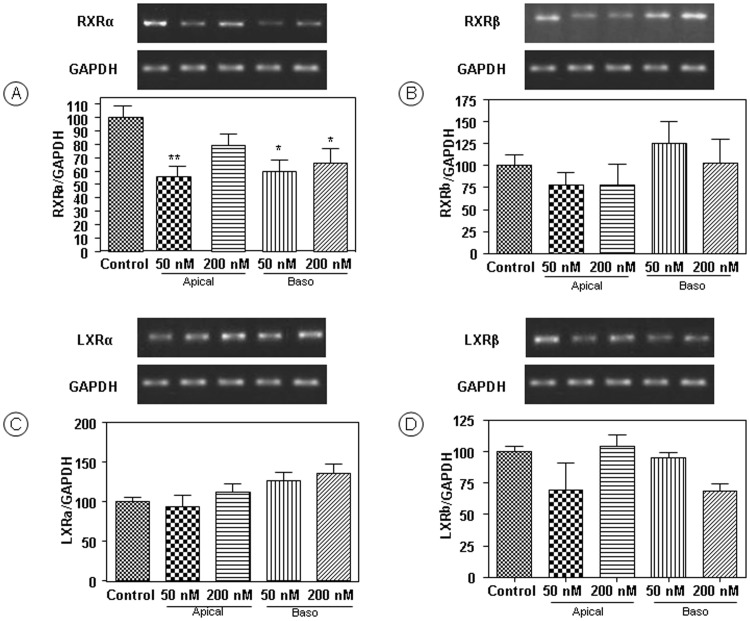
Effects of the administration of PYY (1–36) to the apical or basolateral medium on RXR and LXR gene expression in Caco-2/15 cells.PCR analysis was performed on Caco-2/15 cell line at 14 days post-confluence to analyze mRNA of RXRα (A), RXRβ (B), LXRα (C), LXRβ (D). Values represent means ± SD for n = 3 separate experiments in each group and are reported as % of control values representing 100%. *P<0.05 vs. controls, **P<0.01 vs. controls.